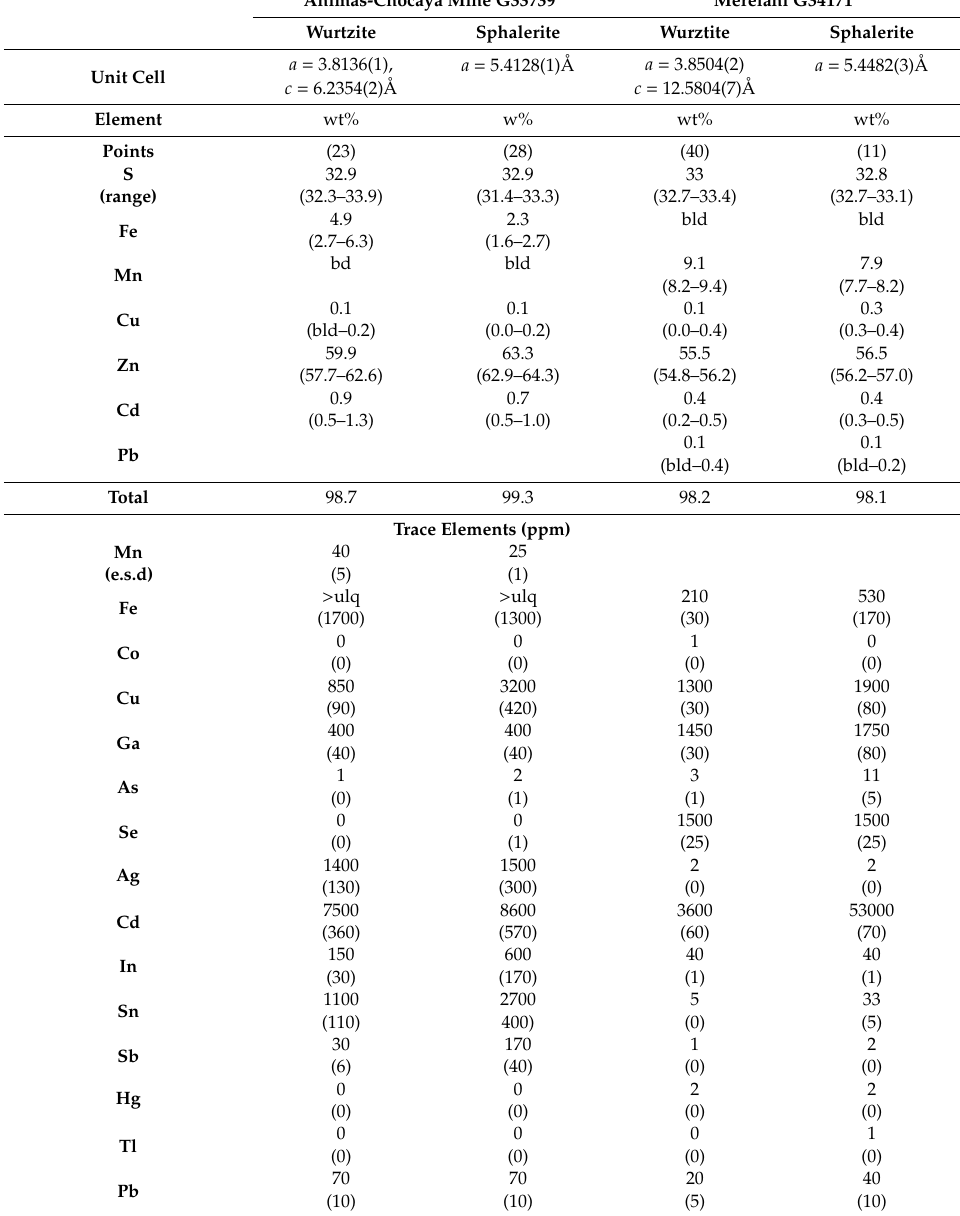
Table 1. Summary of compositional and crystallographic information on epitaxial intergrowths of wurtzite and sphalerite. (ulq) is upper limit of accurate quantification, (bld) below level of detection, (e.s.d) estimated standard